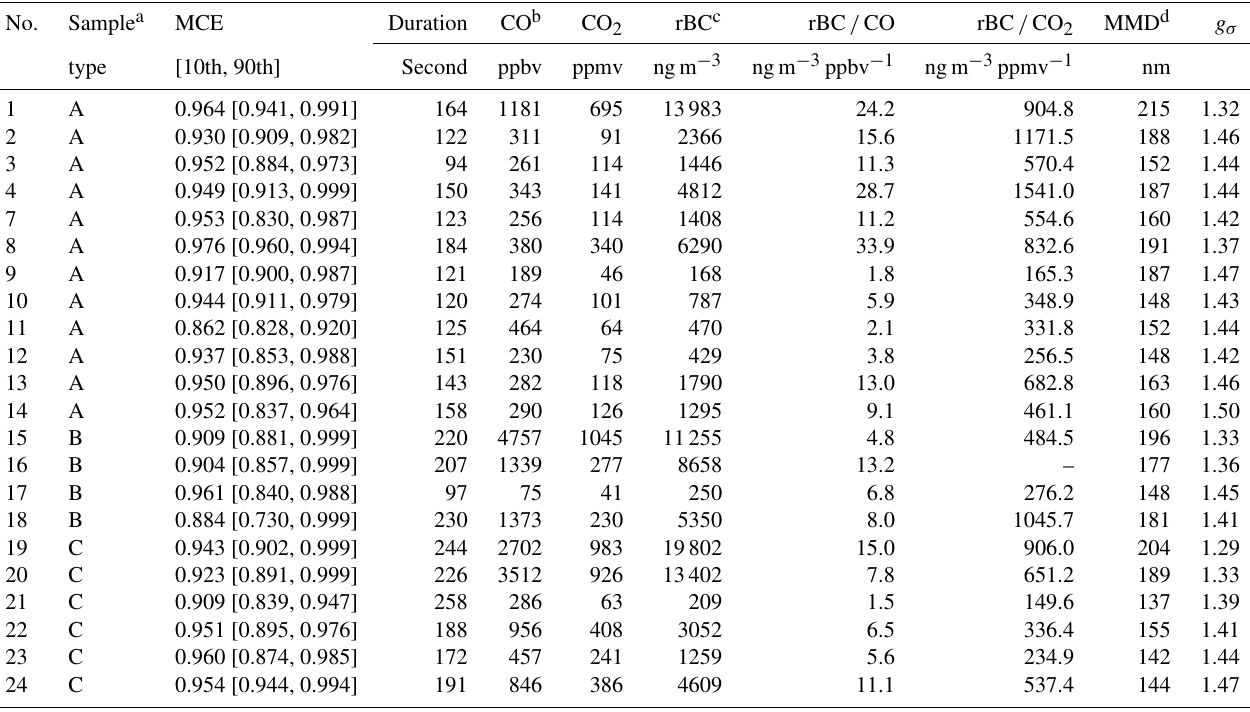
Table 2. Description of sample types; overall combustion states; CO, CO 2 , and rBC concentrations; MMD and geometric standard deviation ( g σ ) of rBC; and emission ratios for the burning experiments. The ordering of these quantities is the same as in previous studies (Inomata et al.,